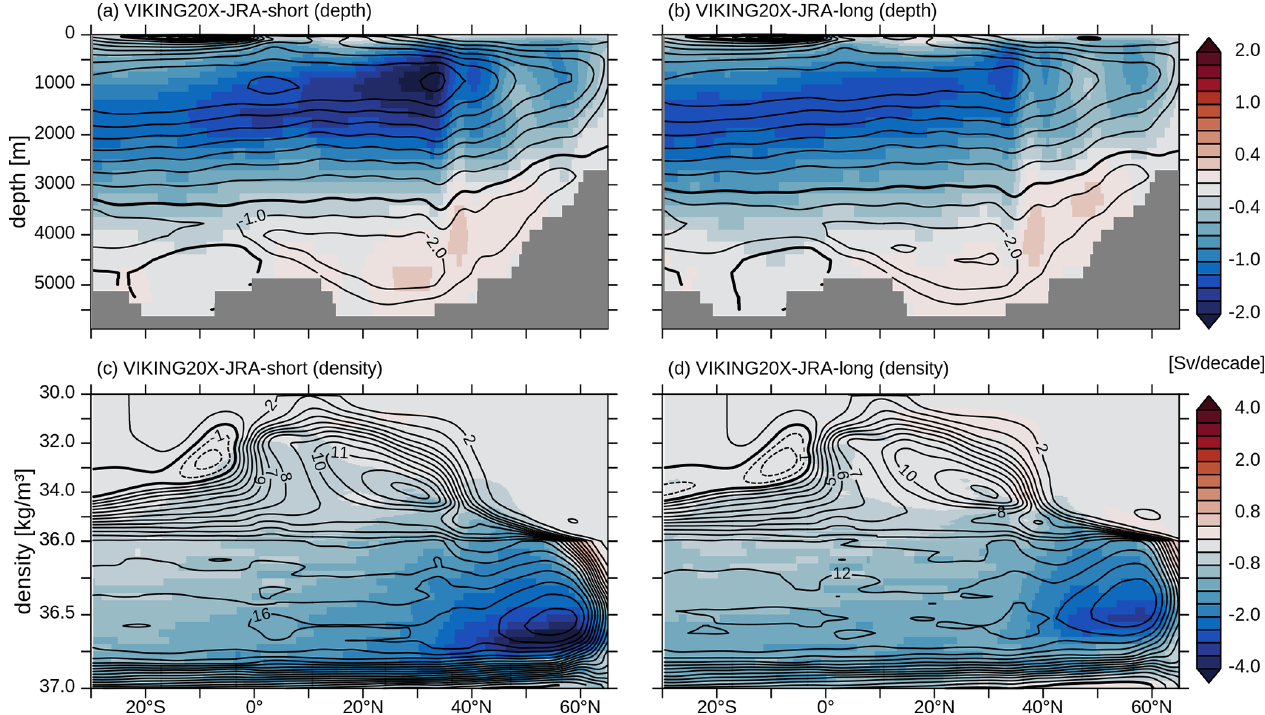
Figure A2. Mean (contours, in Sv) and linear trend (shading, in Sv per decade) in the AMOC in (a) and (b) depth and (c) and (d) density ( σ 2 ) coordinates for the period 2000–2019 for VIKING20X-JRA-short and VIKING20X-JRA-long. All fields are meridionally smoothed with a Hanning filter of 10 ◦ window